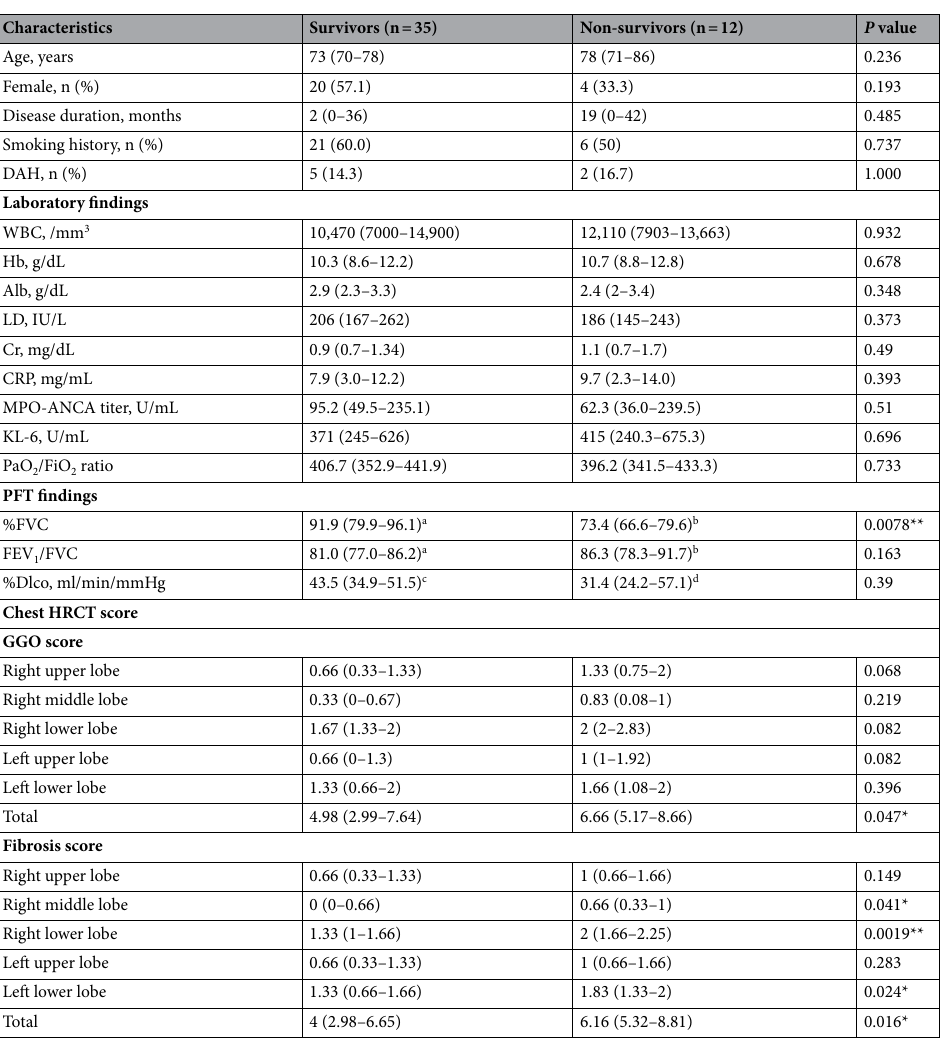
Table 3. Comparison of clinical characteristics, and contents of treatment between survivors and non- survivors in MPA with ILD. The laboratory markers are presented as the median (interquartile range). The P-values were estimated using Fisher’s exact test or Wilcoxon rank sum test. MPA microscopic polyangiitis, ILD interstitial lung disease, DAH diffuse alveolar hemorrhage, WBC white blood cell, Hb hemoglobin, Alb albumin, LD lactate dehydrogenase, Cr creatinine, CRP C-reactive protein, MPO-ANCA myeloperoxidase-anti- neutrophil cytoplasmic autoantibody, KL-6 Krebs von den Lungen-6, PaO 2 /FiO 2 ratio arterial partial pressure of O 2 and the fraction of inspired oxygen ratio, PFT pulmonary function test, FVC forced vital capacity, FEV forced expiratory volume in one second, Dlco diffusing capacity of the lung for carbon monoxide, HRCT high resolution computed tomography, GGO ground-glass opacity. *P < 0.05, **P < 0.01. a Number of subjects, n = 26. b Number of subjects, n = 11. c Number of subjects, n = 25. d Number of subjects, n =